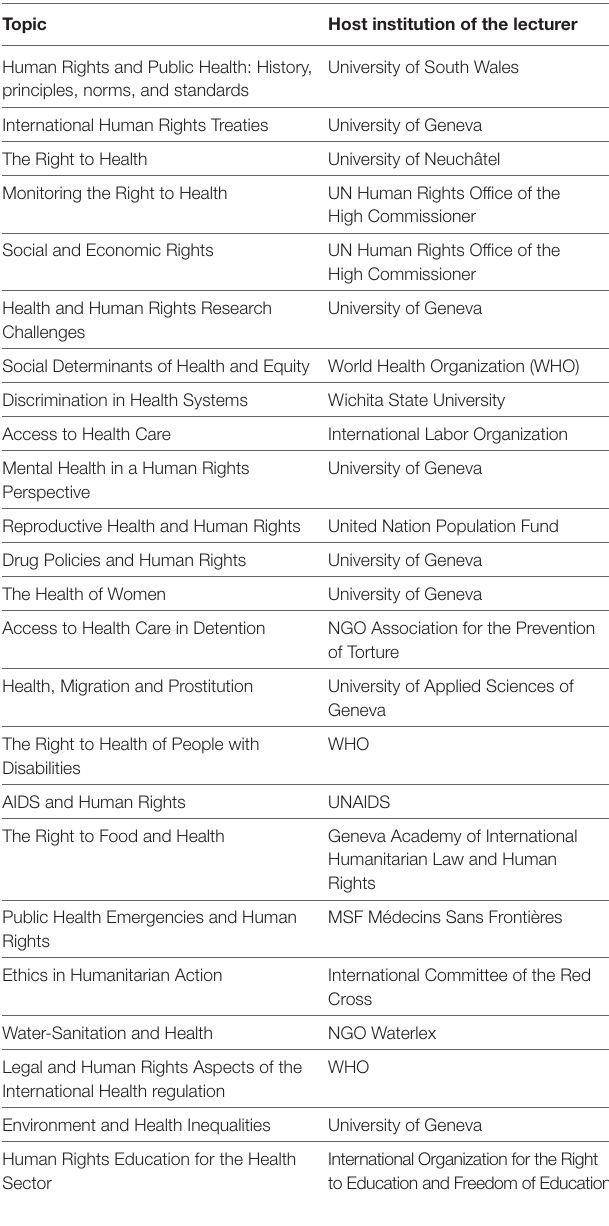
table 1 | Examples of lectures on specific Health and Human Rights topics over the